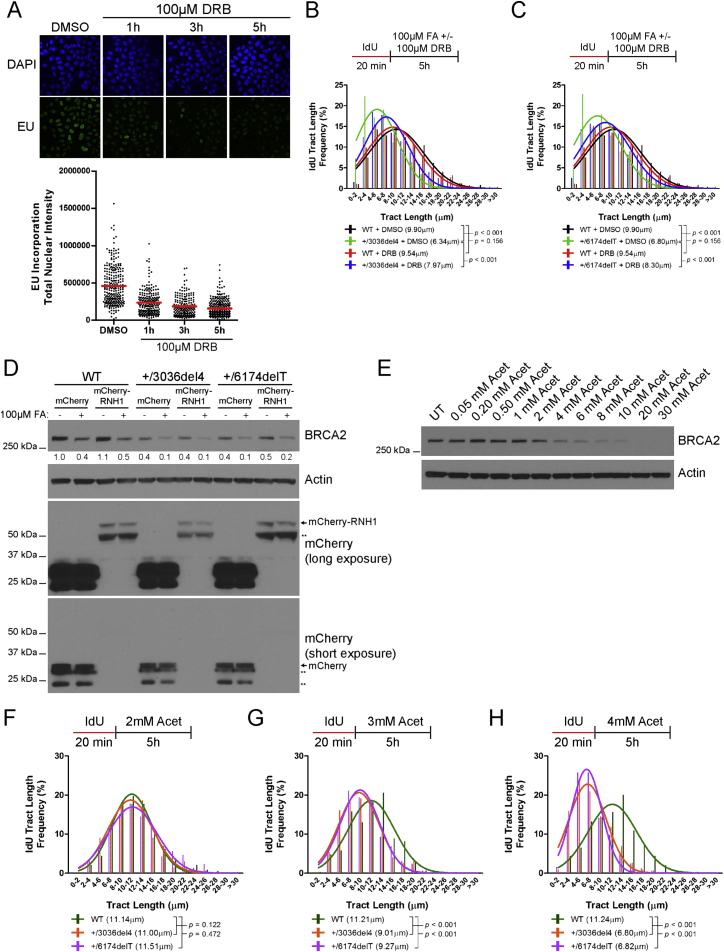
Related to Figure 7(A) Immunofluorescence images of wild-type HeLa Kyoto cells treated with the transcription inhibitor, 5,6-dichloro-1-β-D-ribofuranosylbenzimidazole (DRB) at 100μM for the indicated lengths of time and subsequently labeled with EU for 1h as measure of total RNA synthesis. The scatterplot shows the total nuclear intensities of EU signal from at least 200 nuclei per condition with red lines indicating the median and each dot representing a single nucleus.(B and C) IdU tract length frequency distributions in HeLa Kyoto cells after concurrent treatment with 100μM FA and 100μM DRB for 5h.(D) BRCA2 protein levels in HeLa Kyoto cells expressing mCherry or mCherry-RNase H1 vectors after exposure to 100μM FA for 5h. Numbers below the BRCA2 blot represent densitometric measurements of BRCA2 protein levels normalized to loading control and lane 1 of the BRCA2 blot. Different exposures of mCherry blots show expression of mCherry and mCherry-RNase H1 as indicated. Double asterisks (∗∗) indicate probable degradation products.(E) BRCA2 protein levels in wild-type HeLa Kyoto cells after treatment with increasing doses of acetaldehyde for 5h.(F–H) IdU tract length frequency distributions in HeLa Kyoto cells after treatment with 2, 3 or 4 mM acetaldehyde for 5h.